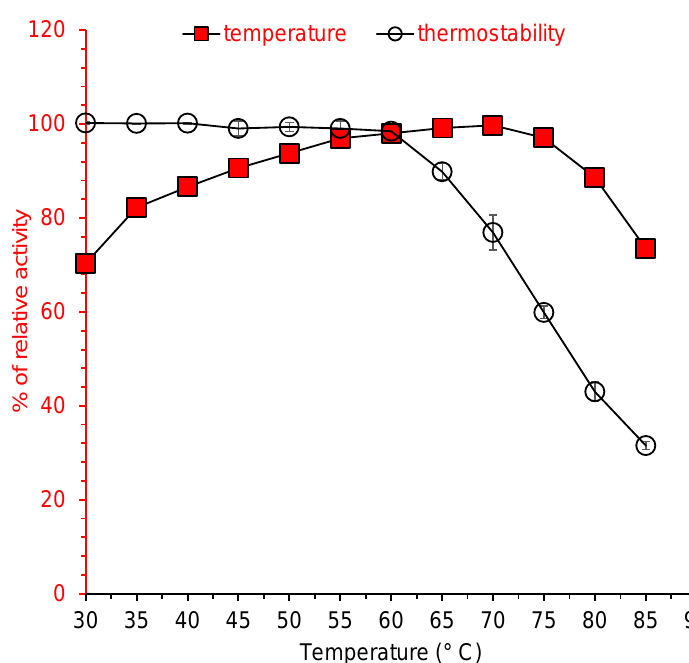
Figure 7. The effect of temperature and thermostability on crude amylase produced by Bacillus sp. BCC 021-50. The enzyme was mixed with substrate and incubated at different temperatures for 30 min. Percentage of relative activity was measured under assay conditions. Thermostability of amylase was determined by incubating the enzyme at different temperatures without the addition of substrate for 1 h. Percentage of relative activity was checked under assay conditions. The results are the average of triplicate experiments and the data presented in the figure are the average of three parallel experiments. Error bars are shown for standard deviation.